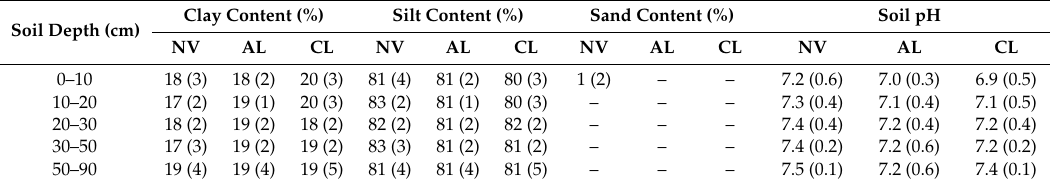
Table 1. Soil particle distribution and soil pH at di ff erent stages after agricultural abandonment. Soil Depth (cm)